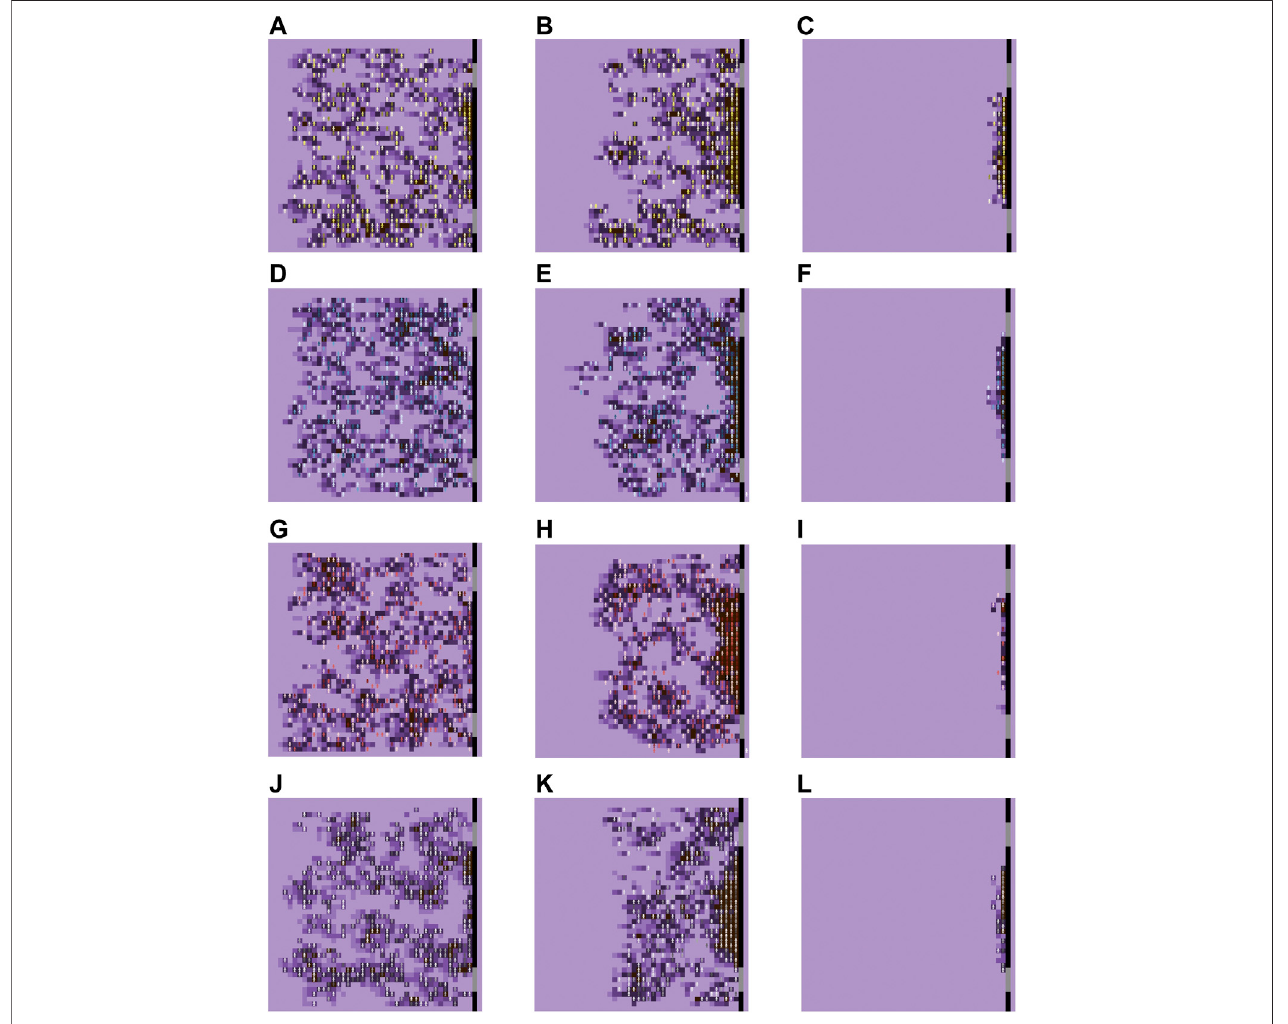
FIGURE 5 | Evacuation patterns for 2-agent groups (A – C) , 3-agent groups (D – F) , 4-agent groups (G – I) and 5-agent groups (J – L) . Different patterns for the movable,jammedandrare fi edphasesareexhibitedfromlefttoright.Thegradientofpurplecolorinthebackgroundindicatesthestrengthofthedynamic fl oor fi eld.Inthe jammed phase, the dynamic fl oor- fi eld